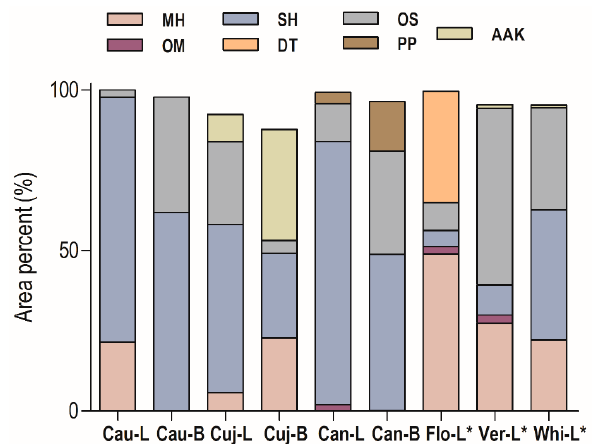
Figure 1. Distribution of compound classes in essential oils (Eos) of Ocotea species. Monoterpene hydrocarbons ( MH ), Oxygenated monoterpenoids ( OM ), Sesquiterpene hydrocarbons ( SH ), Oxygenated sesquiterpenoids ( OS ), Diterpenes ( DT ), Phenylpropanoids ( PP ), Alkanes, aldehydes, and ketones ( AAK ). O. floribunda leaves ( Flo-L ), O. veraguensis leaves ( Ver-L ), O. whitei leaves ( Whi-L ); * Literature data [22]. Cau-L ( O. caudata leaves); Cau-B ( O. caudata bark); Cuj-L ( O. cujimary leaves); Cuj-B ( O. cujimary bark); Can-L ( O. caniculata leaves); Can-B ( O. caniculata bark).